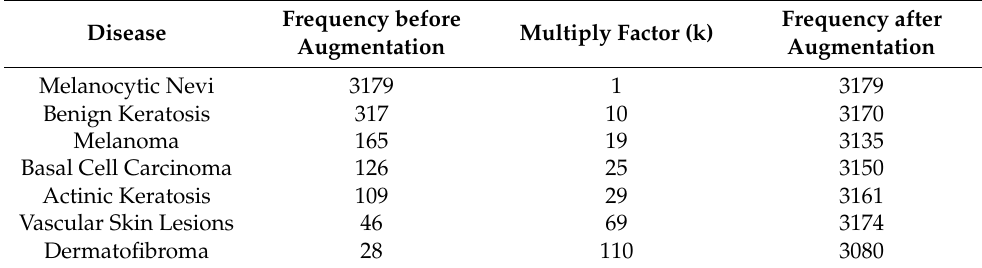
Table 1. Data augmentation of the